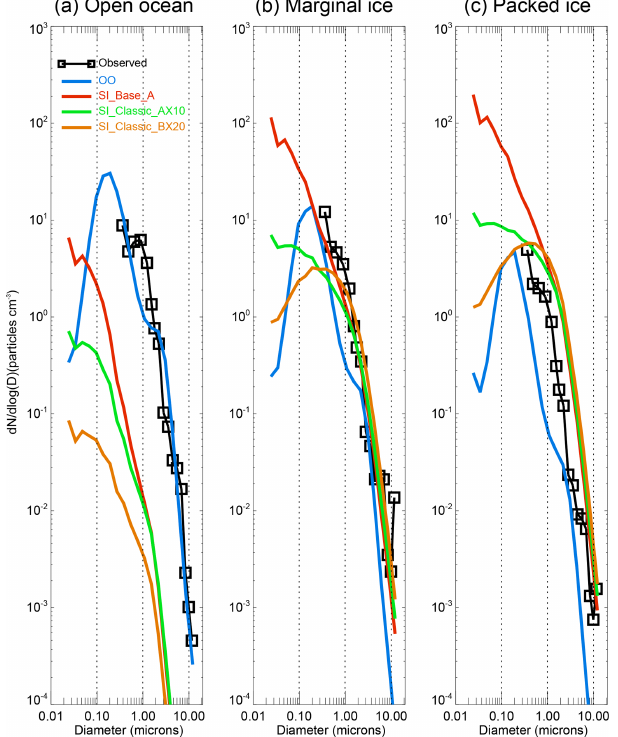
Figure 4. Size distribution of sea spray and sea-ice-soured SSA at three defined surface zones: (a) open ocean, (b) marginal sea ice, and (c) packed sea ice zone. Observations are shown by the black lines with box symbols. Open-ocean sea spray comes from the OO run (blue). Sea-ice-sourced SSA from the control run SI_Base_A (red) and two SI_Classic runs. Note that SI_Classic_AX10 (green) is the same as SI_Classic_A but applying a ratio of 10 SSA pro- duced per blowing-snow particle; SI_Classic_BX20 (orange) is the same as SI_Classic_B but applying a ratio of 20 (Table 1). Vertical dashed lines represent a diameter of 0.1, 10 and